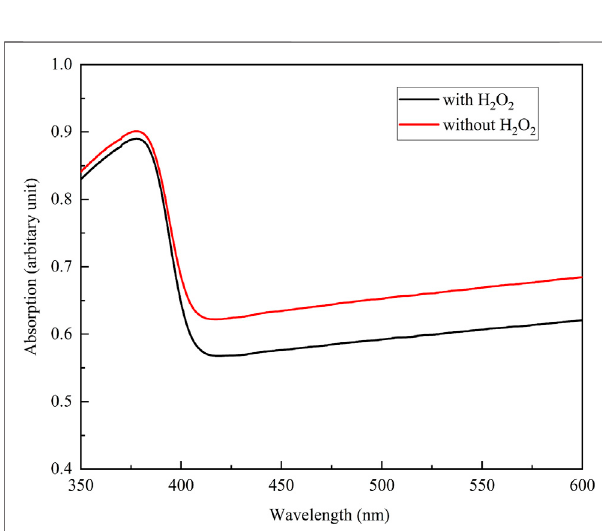
FIGURE 5 | The chemical composition of investigated anodic oxides on the TiNbSn alloy calculated by semi-quantitative analysis using the XPS spectra. The sample size is n = 1 in each group. XPS: X-ray photoelectron spectroscopy.